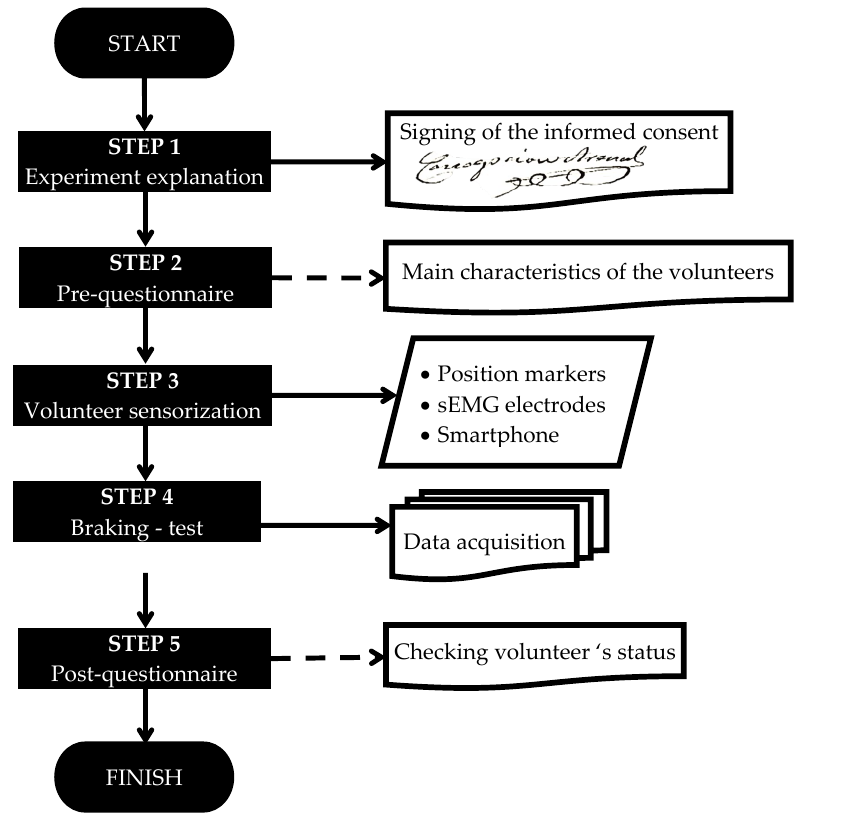
Figure 1. Steps to complete the emergency braking test. Based on [20].